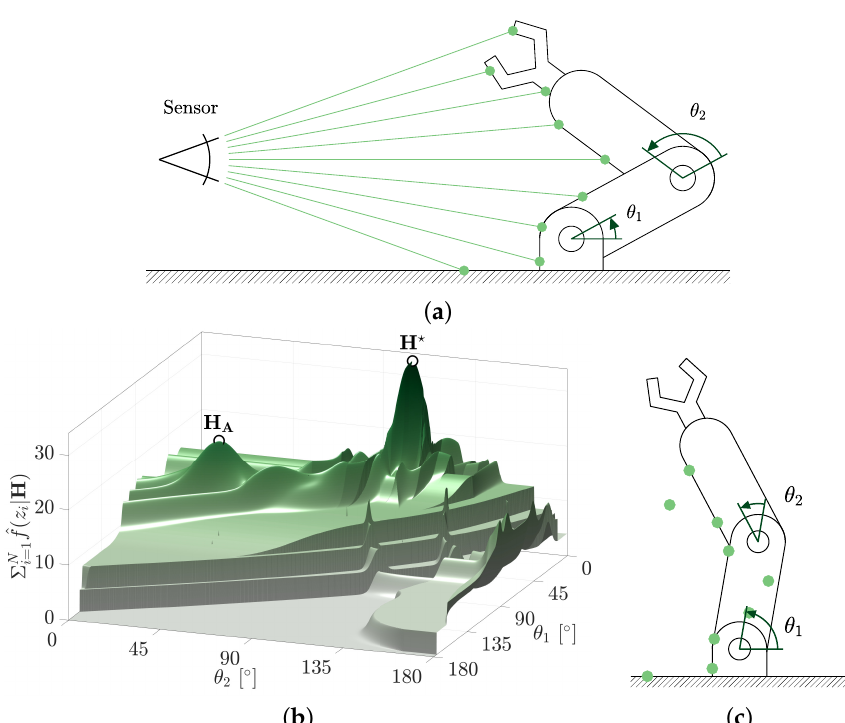
Figure 8. An example 2-DOF problem used to explore the challenges of searching the hypothesis space, H , for the global maximum sum of evidence solution, H (cid:63) . ( a ) Geometry and measurements of the example two degree of freedom estimation problem. ( b ) The sum of conditional likelihoods of the nine range measurements evaluated across the hypothesis space, H = [ θ 1 , θ 2 ] . ( c ) Incorrect local maximum sum of evidence at pose H A .